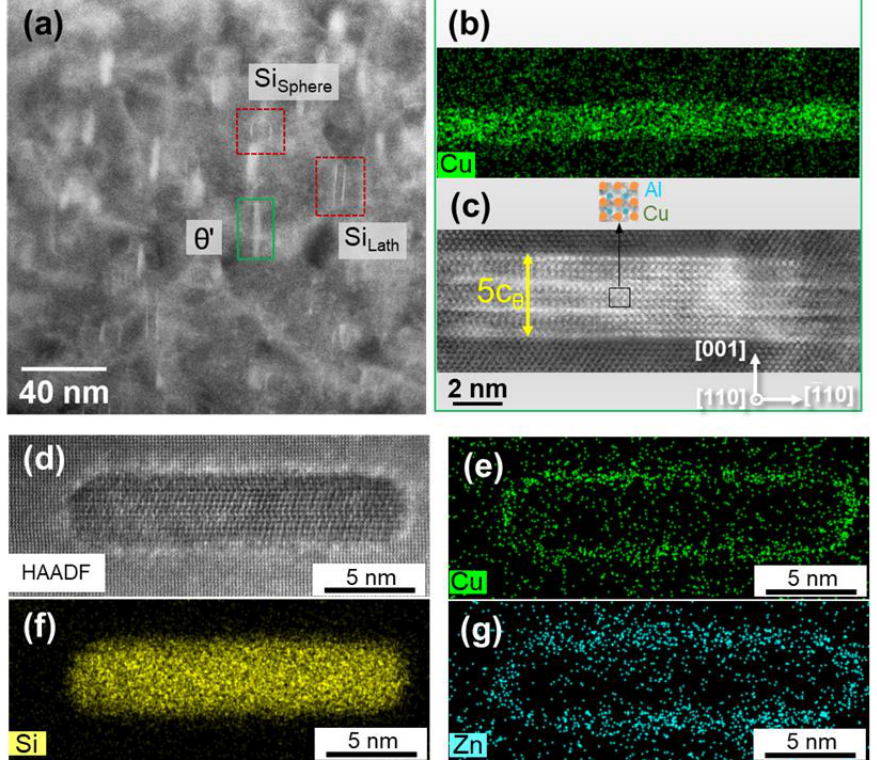
Figure 11. STEM HAADF images and EDS analysis of precipitates found in the LM24-M alloy after T5 aging treatment. ( a ) Low-magnification HAADF image showing the coexistence of θ ’-Al 2 Cu and Si precipitates. ( b , c ) EDS map and atomic resolution HAADF image of the θ ’-Al 2 Cu precipitate highlighted in ( a ). ( d – g ) atomic resolution HAADF image and EDS maps of a lath-like Si precipitate acquired along the beam direction parallel to (cid:104) 111 (cid:105) Al. Reprinted with permission from Ref. [56]. Copyright 2022,